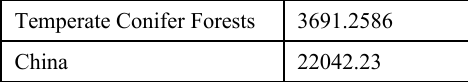
Table 5. Forest area in different forest